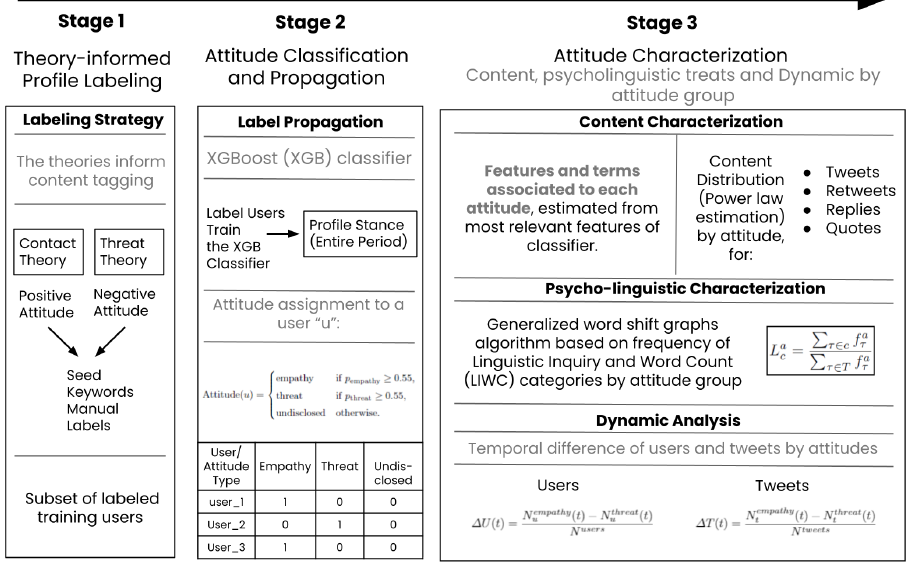
Figure 3. Schematic diagram of the proposed